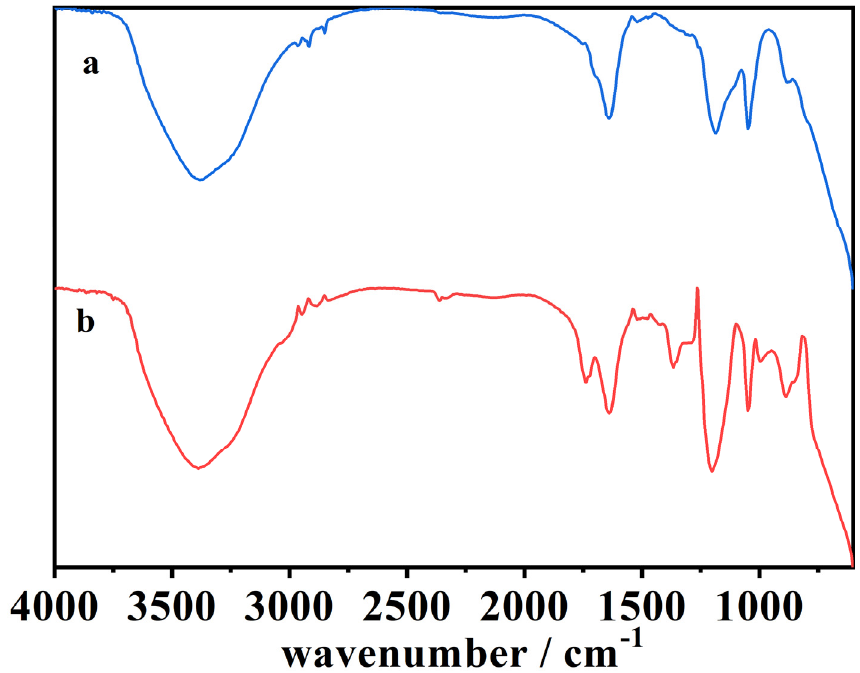
Figure 10. The ATR-FTIR spectra of ( a ) the aqueous phase of the blank cork bio-oil acidic emulsion, not subjected to electrolysis, and ( b ) the aqueous phase of the acidic emulsion after Electrolysis II, a bulk electrolysis in a single-compartment cell.